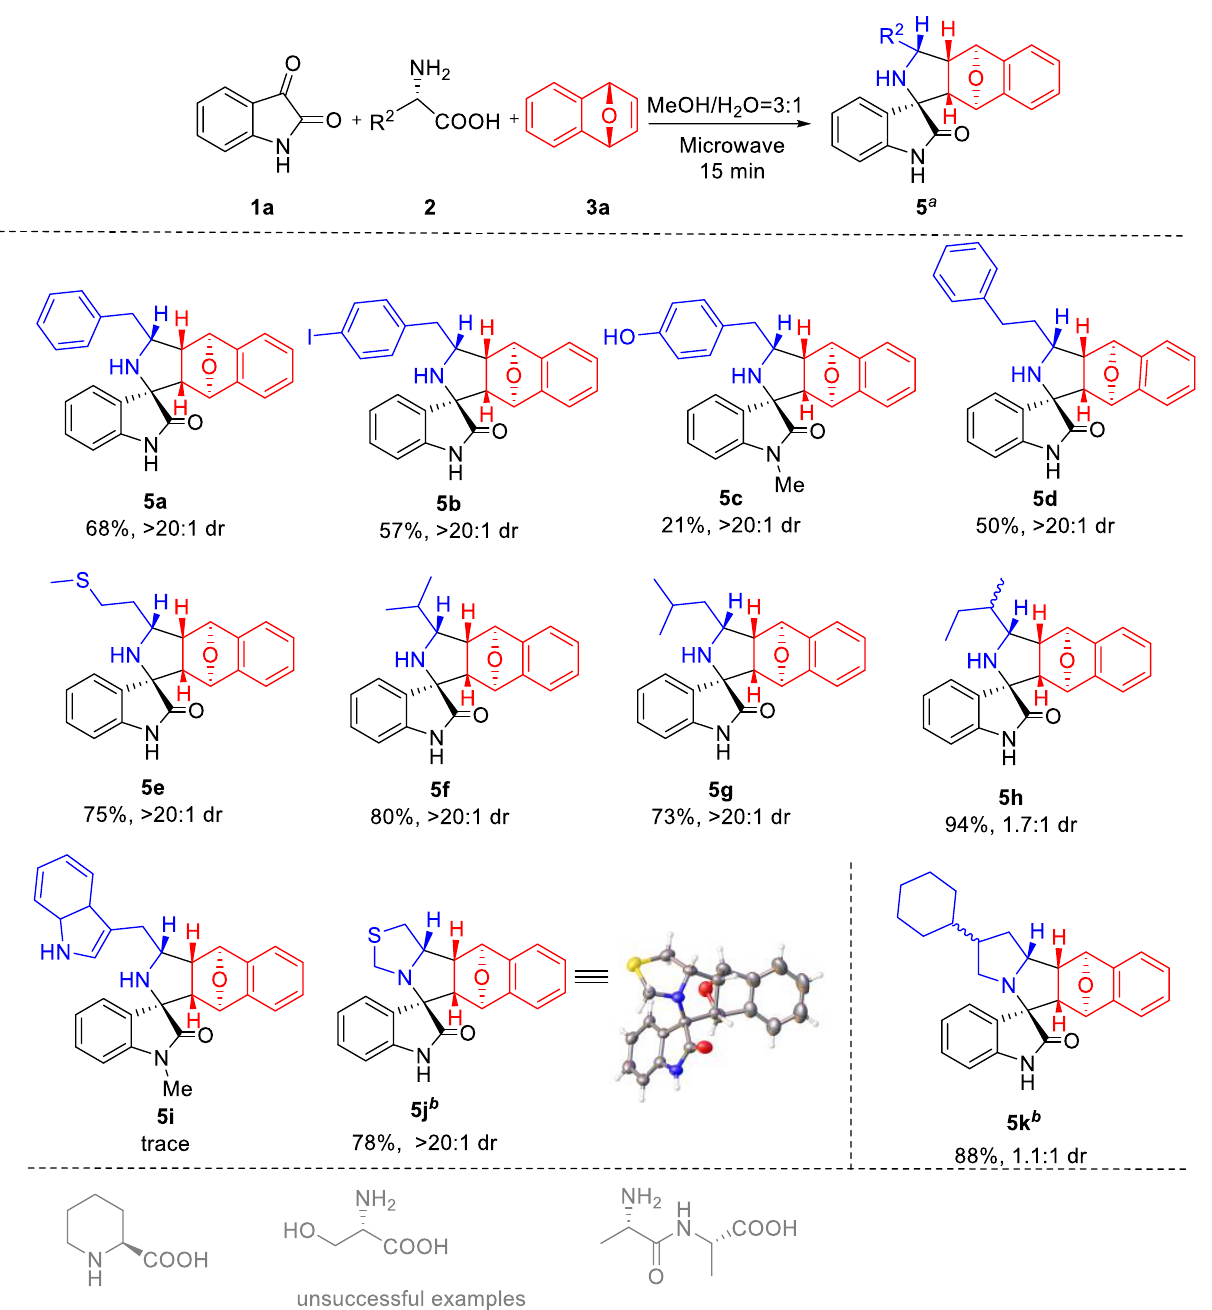
Scheme 3. Reaction scope with respect to amino acids a . a Reagents and conditions: 1a (0.20 mmol),